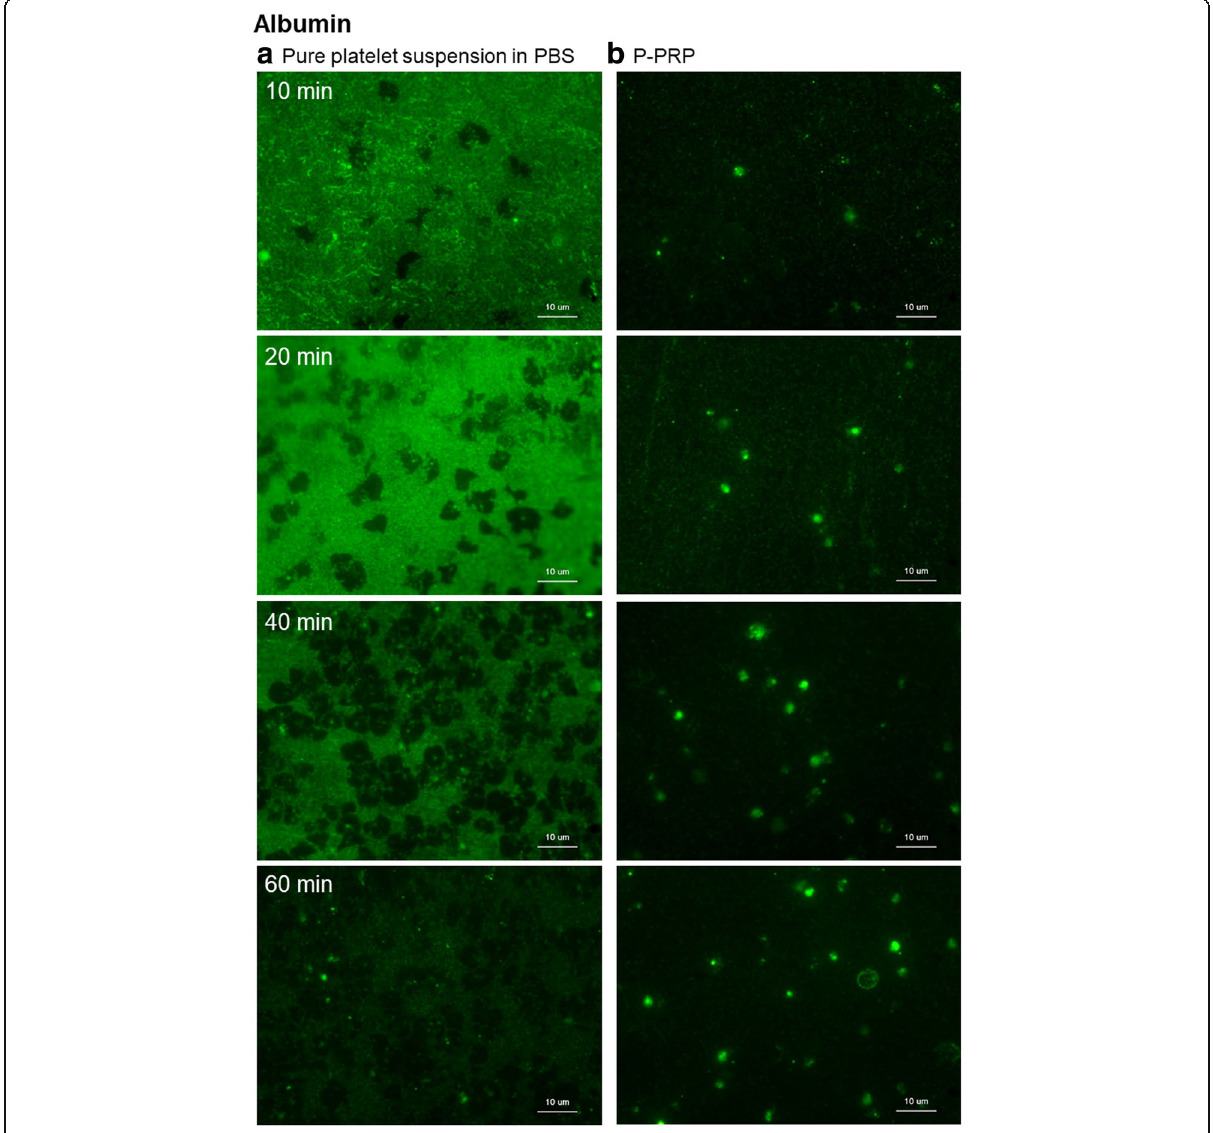
Fig. 7 Distribution of serum albumin (green dye) on the surface of cp -Ti plates. a Platelets suspended in PBS and b P-PRP. cp - Ti commercially pure titanium, PBS phosphate-buffered saline, P - PRP pure platelet-rich